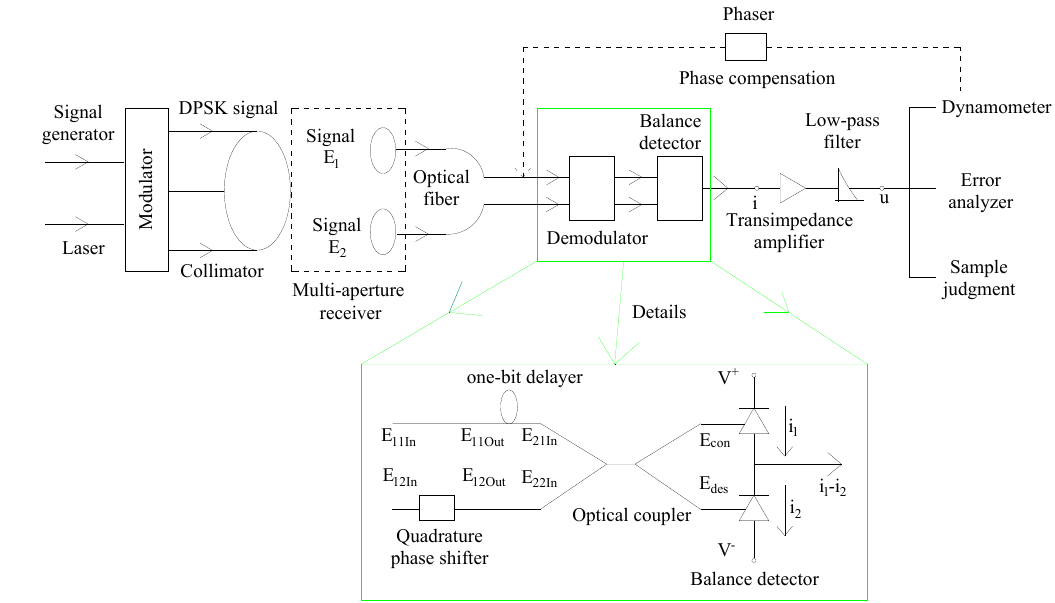
Figure 1. The array optical communication telescope system.